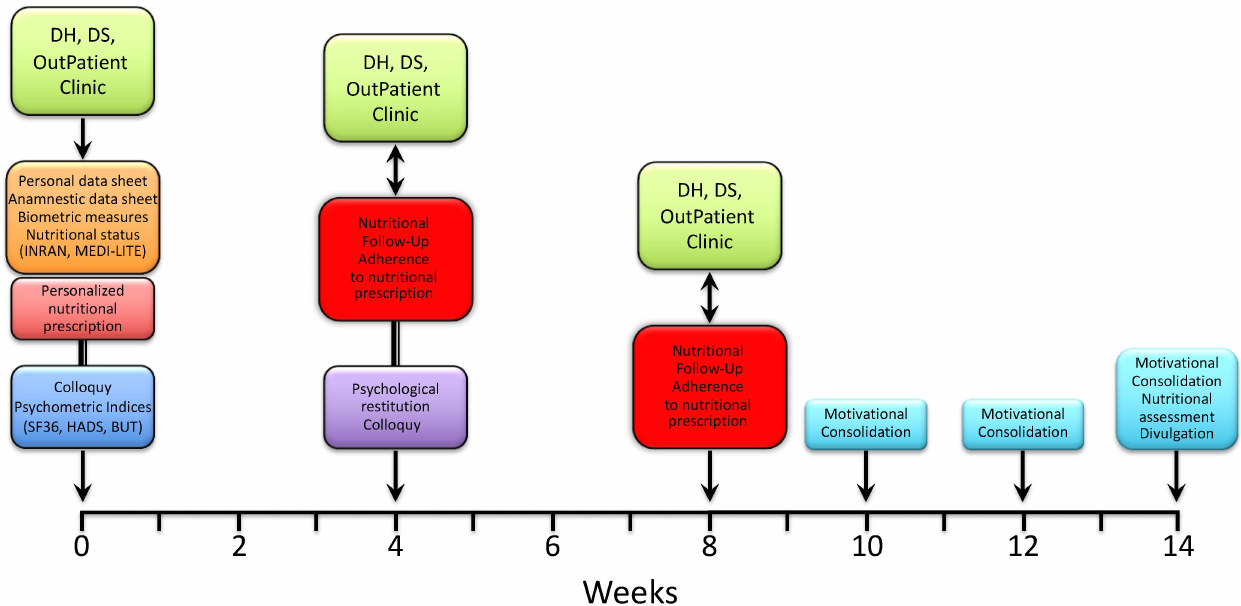
Figure 2. Timeline of the nutritional and psychological intervention